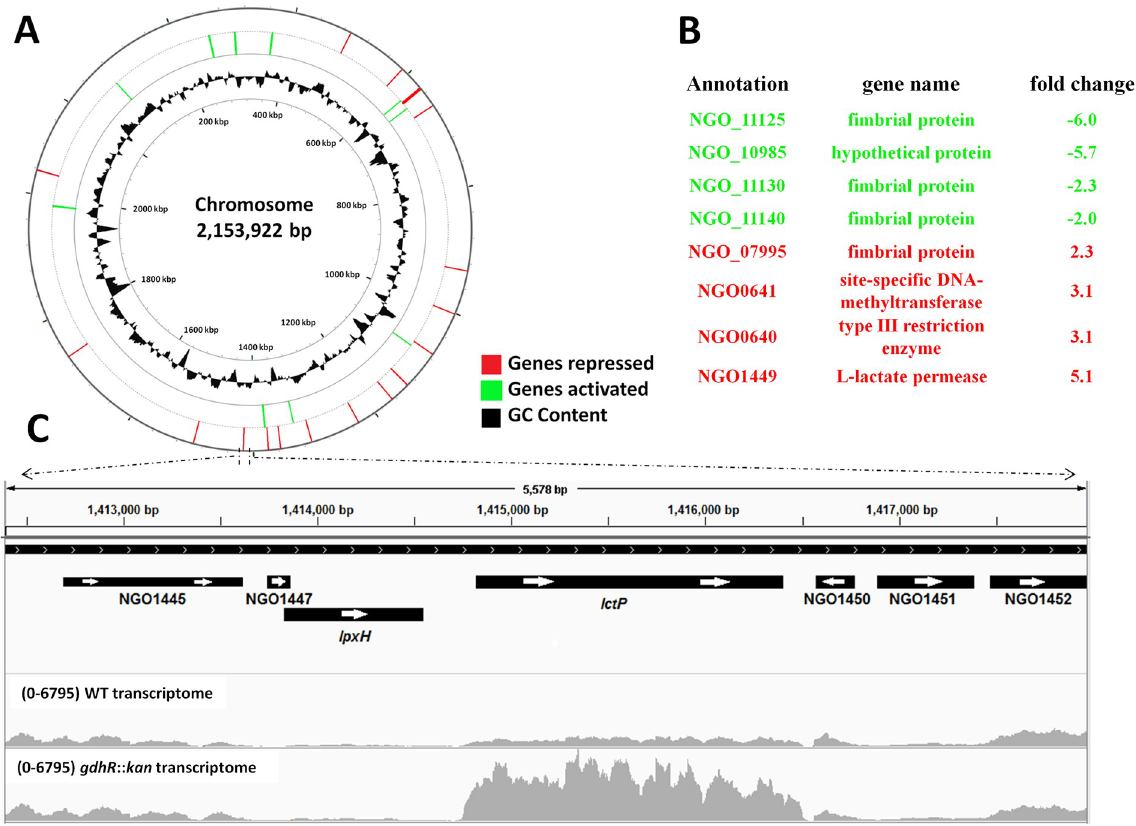
Fig 1. Genome-wide GdhR regulon during late-exponential growth. A. Graphic representation generated by CG viewer [67], depicting the Neisseria gonorrhoeae chromosome showing GdhR-regulated genes determined by RNA-Seq. N . gonorrhoeae cells were grown in GC broth at 37˚C and collected at late-exponential phase for RNA-Seq. The numbering indicated within the inner circle represents the chromosome coordinates in kb pairs. B. List of GdhR-repressed and -activated protein-coding genes compiled at a fold change higher than 2. C. Transcription profile of the lctP locus in FA19 WT and gdhR mutant gonococci. BAM files containing the sequence reads for the WT (GEO sample number GSM3981651) and gdhR :: kan (GSM3981653) cells transcriptomes were aligned to the FA19 strain genome and visualized using IGV software [68]. Genes are represented using the FA1090 annotation system. Numbers in parenthesis indicate the maximum read count in the (y) axis.